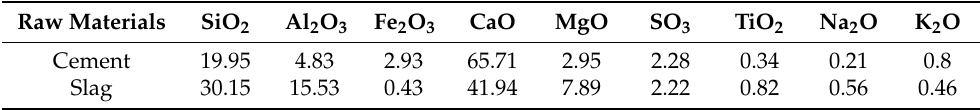
Table 1. Chemical composition of cementitious materials (%).